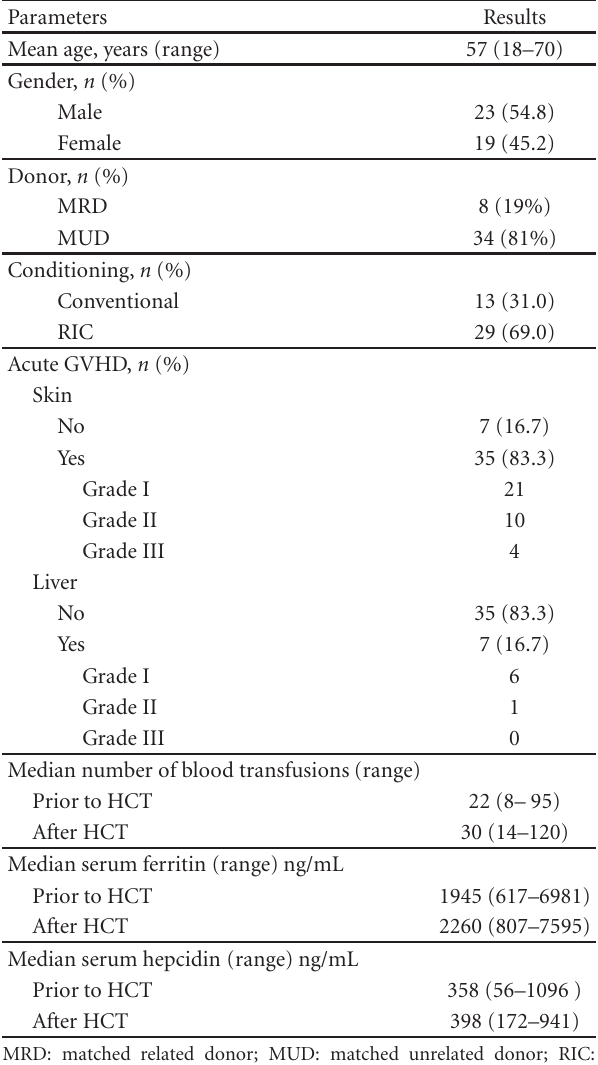
Table 1: Patient characteristics at baseline ( n =